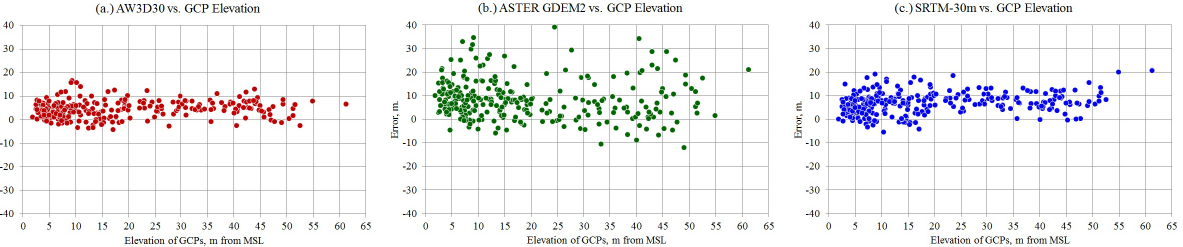
Figure 2: DEM calculated errors plotted with the ground elevation of the GCPs.